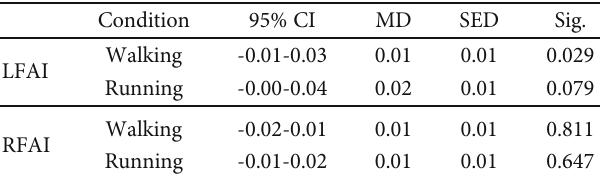
Table 3: Comparison of the arch index in barefoot and shod during walking and